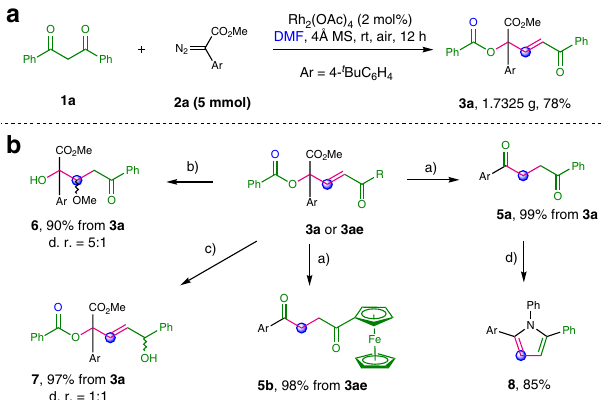
Fig. 3 Gram-scale reaction and functional group transformations. a Gram- scale reaction. b Functional group transformations. Reaction conditions: a 3a (0.1 mmol), LiOH (2 equiv) in THF/H 2 O 4:1 (1 mL) at room temparature. b 3a (0.1 mmol),